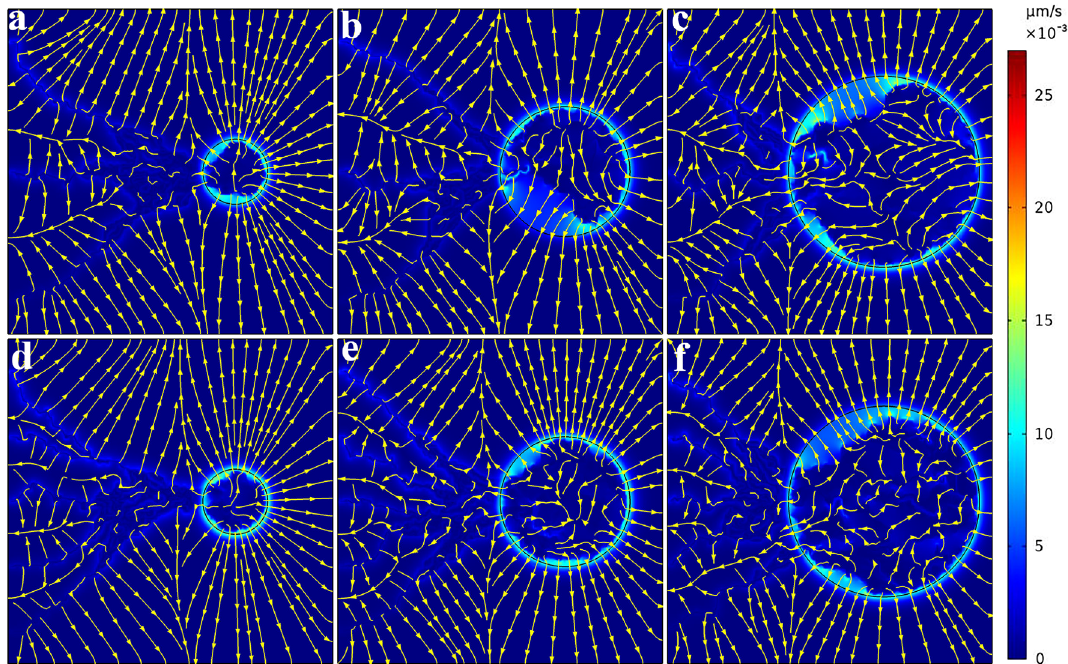
Figure 8. Interstitial fluid velocity distribution for six considered networks. Streamlines are given in each subfigure. IFV has very low values for both tumor and normal tissues. Maximum IFV occurs at the tumor boundary where there is a large IFP gradient. Fluid flow is directed from high pressure areas to low pressure